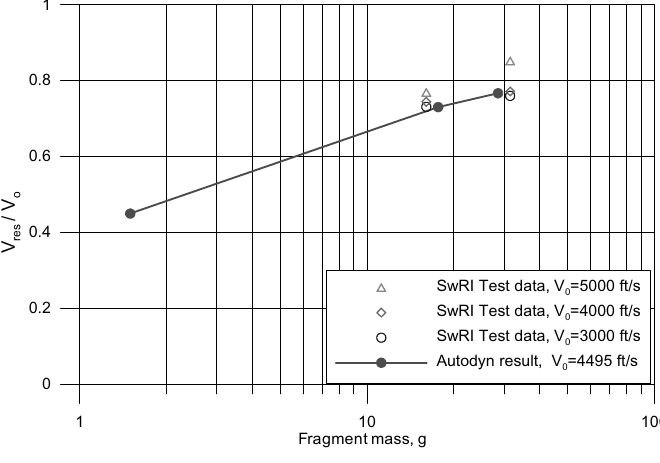
Fig. 11. Residual velocity (as fraction of original velocity) compared to test data.